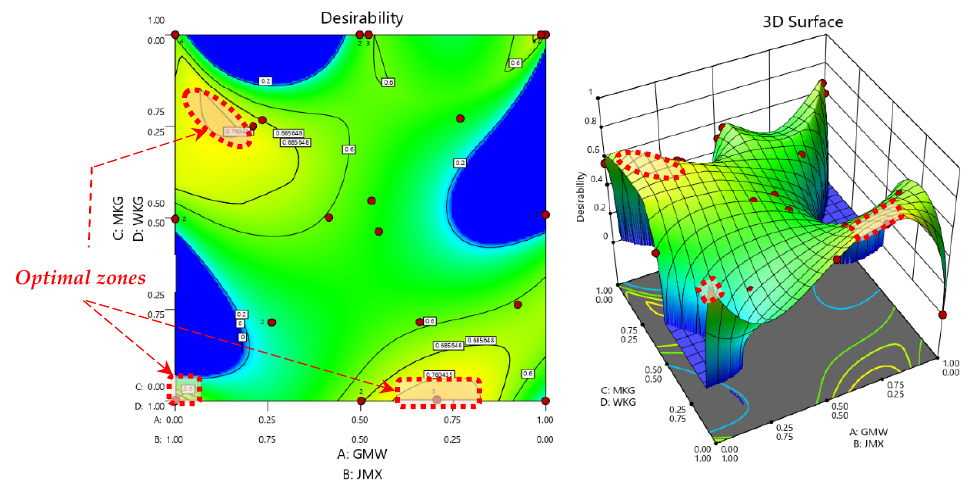
Figure 3. Contour (at left ) and 3D (at right ) plots for the desirability D-function by assuming equal and average importance (3 (+++)) of each response ( ˆ y L , ˆ y Y , ˆ y Ac